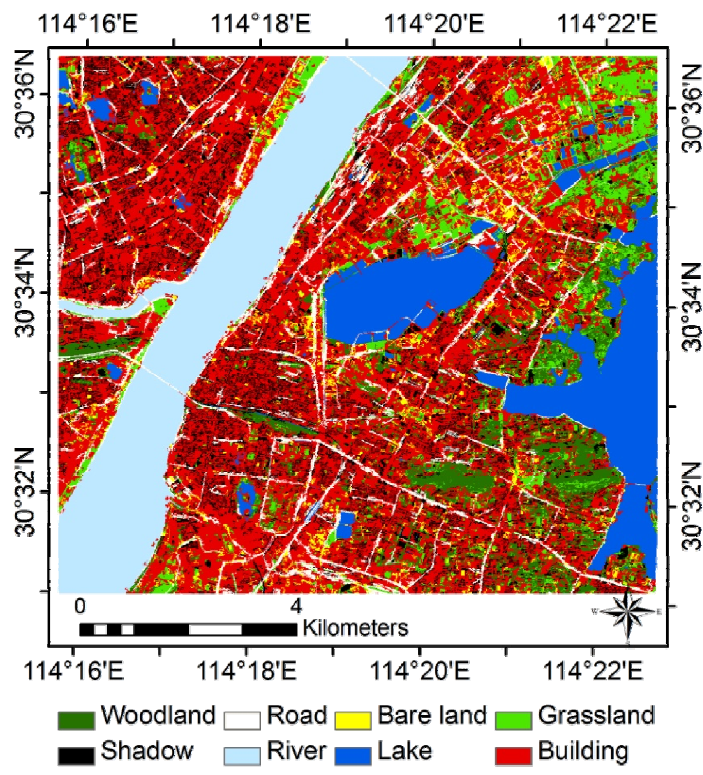
Figure 5. Land use/cover map derived from QB imagery.